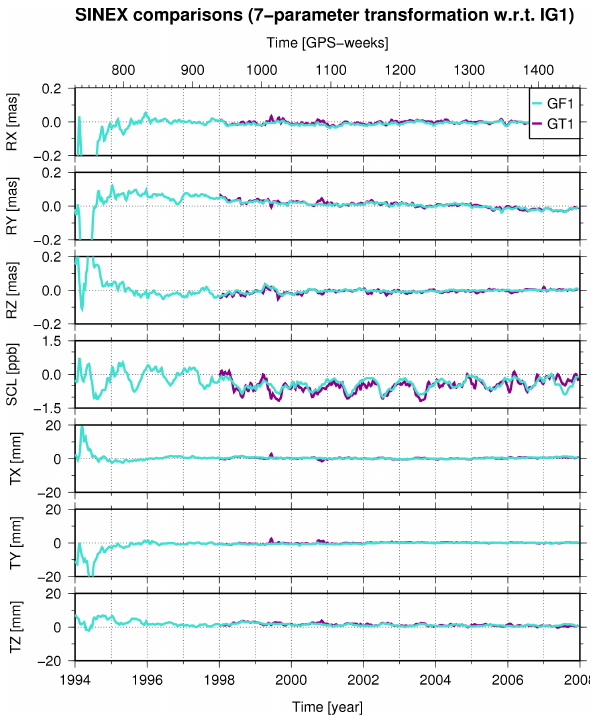
Fig. 4. The time series of weekly Helmert transformation parame- ters (RX-, RY-, RZ-rotations, TX-, TY-, TZ-translations and scale SCL) of the GT1 and GF1 solutions with respect to the IG1 solu-